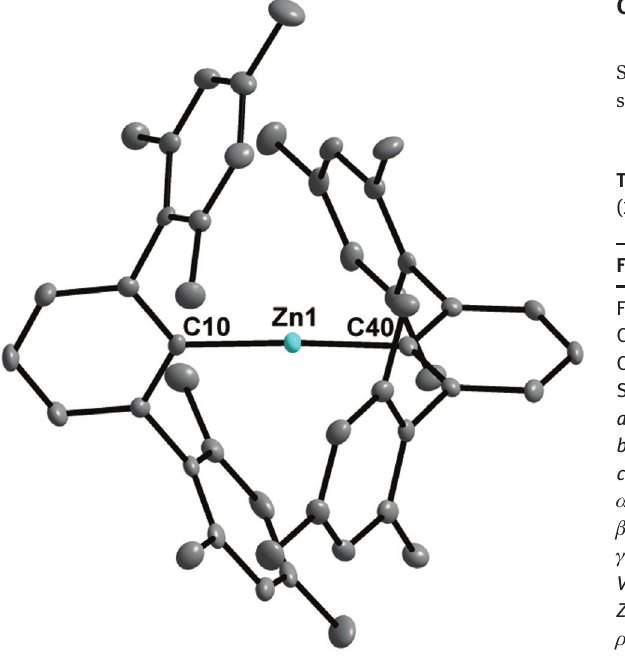
Figure 1 Molecular structure of monoclinic (2,6-Mes showing 30% probability ellipsoids and the crystallographic numbering scheme.